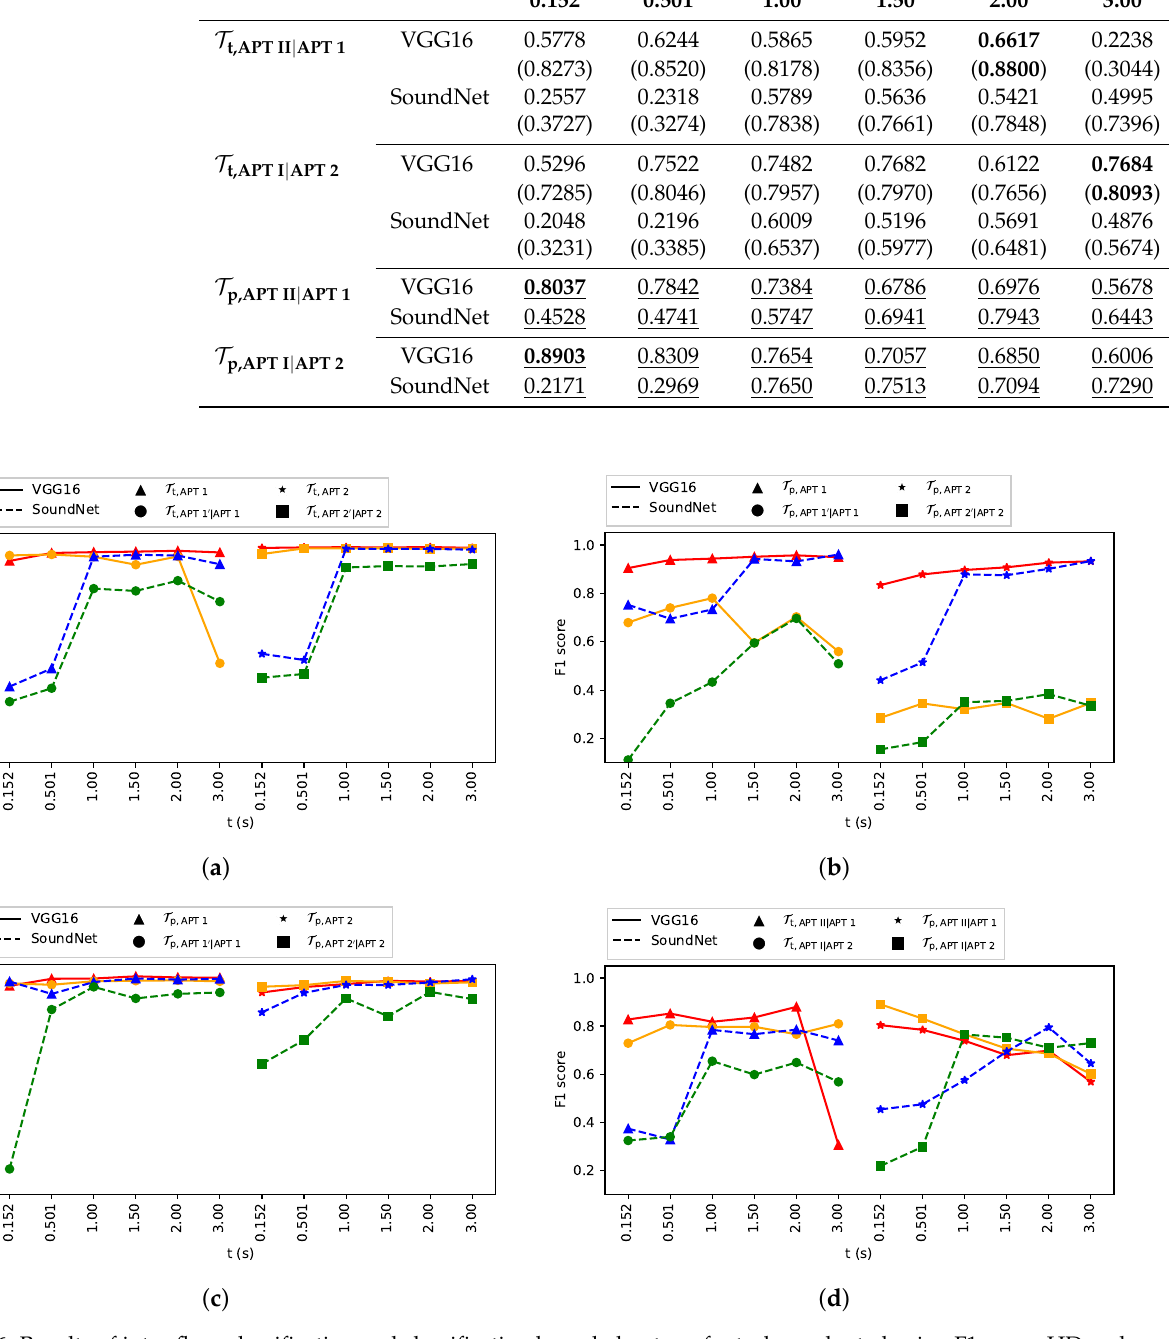
Figure 6. Results of inter-floor classification and classification knowledge-transfer tasks evaluated using F1 score. HD and HH were considered the same category for source type classification results. ( a ) Cross-validation and test results of the source type classification tasks in Table 3. ( b ) Cross-validation and test results of localization tasks in Table 4. ( c ) Rearranged localization results to their corresponding floor. ( d ) Results of the knowledge transfer tasks in Table